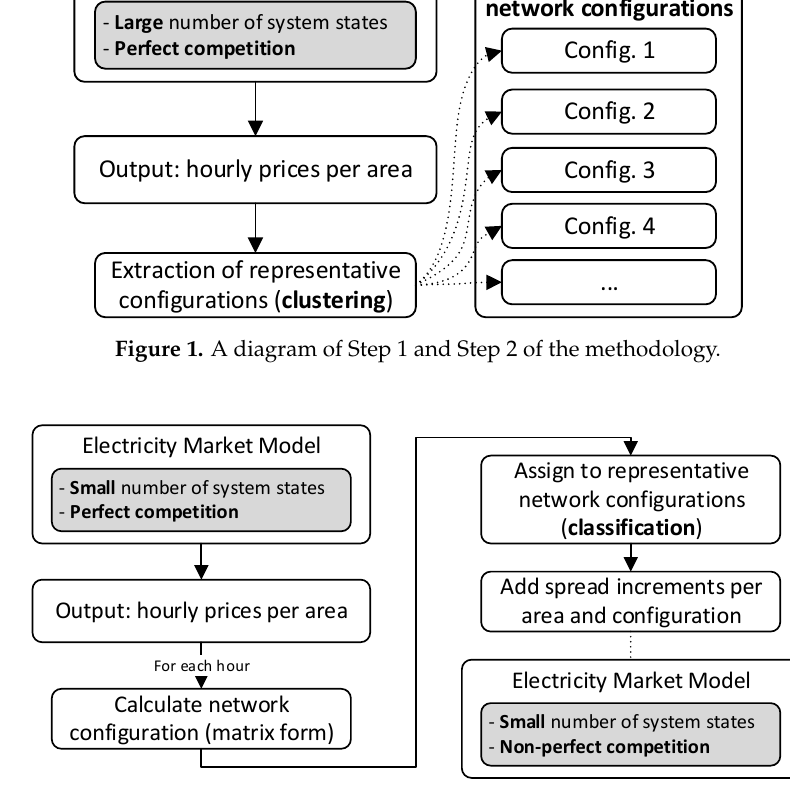
Figure 2. A diagram of Step 4 and Step 5 of the